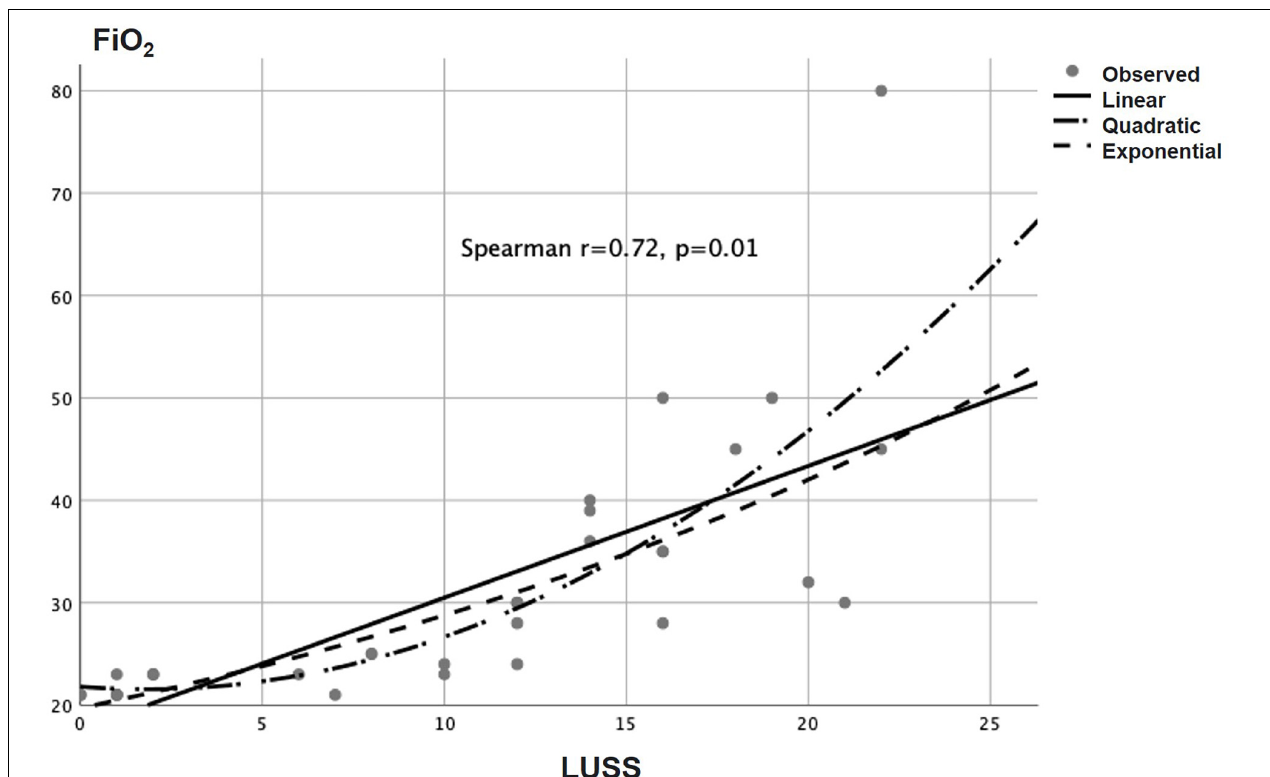
FIGURE 4 | Correlation between LUSS and FiO 2 needed (Spearman r = 0.72, p =